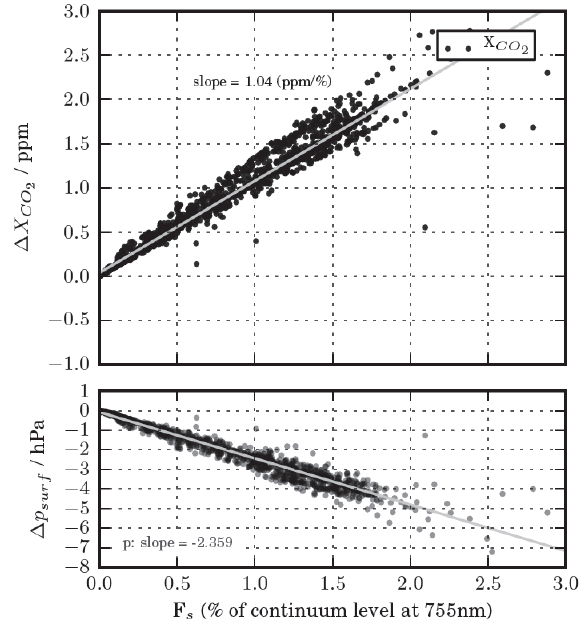
Fig. 3. Case #1a: Changes in retrieved X CO pressure induced by chlorophyll fluorescence if it is ignored in the retrieval step. Both simulation and retrieval use a Rayleigh-only